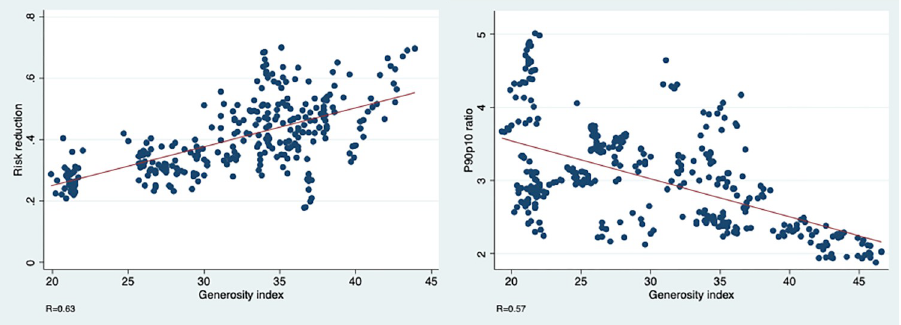
Fig 1. Relationship between generosity, risk reduction indices and the p90p10